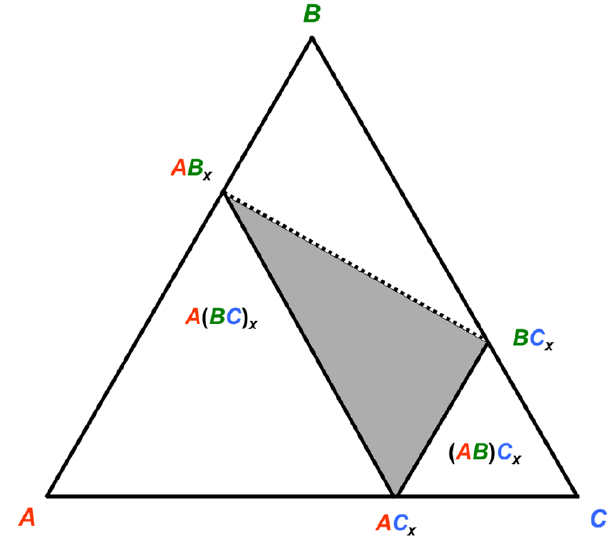
Figure 2. Schematized isothermal section of a system A – B – C in which the compound AC